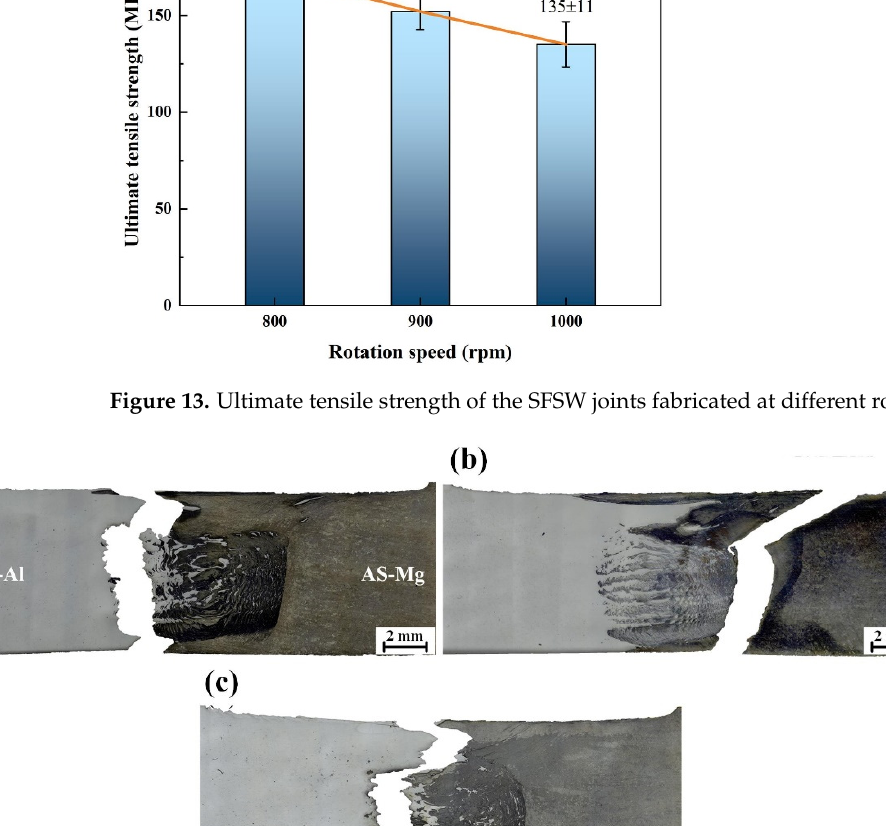
Figure 13. Ultimate tensile strength of the SFSW joints fabricated at different rotational velocities.